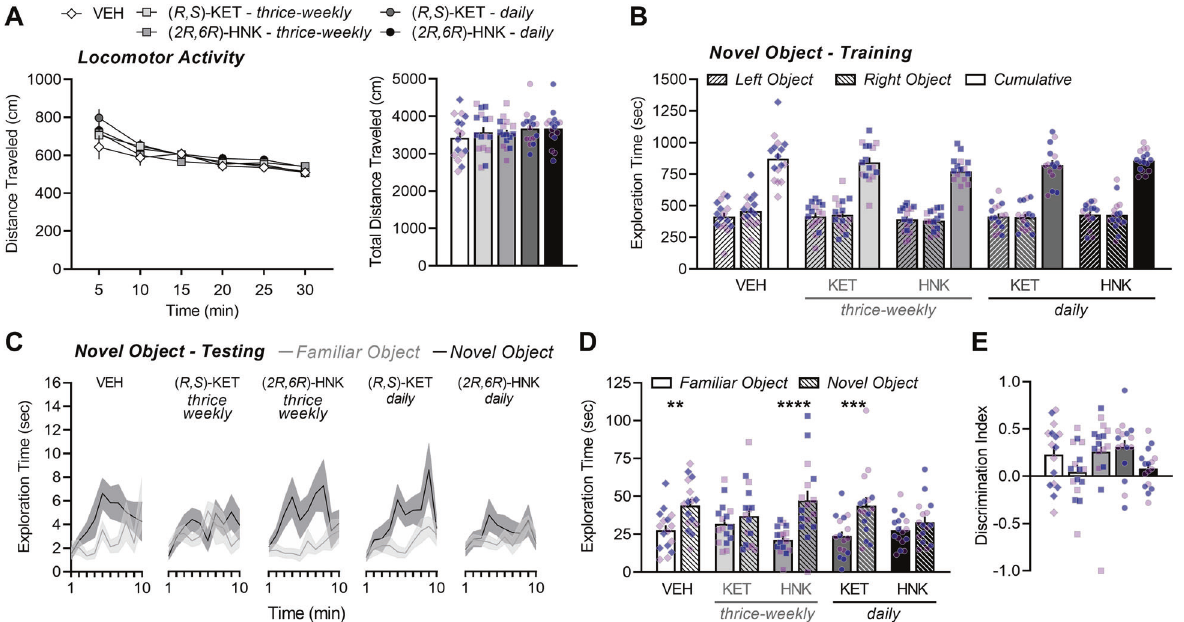
Fig. 3 Adolescents treated with thrice-weekly ( R,S )-ketamine or daily ( 2R,6R )-hydroxynorketamine have impaired novel object recognition in adulthood. A Locomotor activity during the habituation phase of the novel object-recognition task (i.e., in the absence of objects) plotted as 5-min time bins (left) and summarized as total distance traveled over the total 30-min (right). B Total time spent exploring two identical objects during the 30-min of training. C Time spent exploring the familiar object and the novel object across the 10-min of testing. D Total time spent exploring the familiar object and the novel object during the 10-min of testing and ( E ) plotted as a discrimination index (right): (novel-familiar)/(novel + familiar). Data are presented as mean ± standard error of the mean. ** P < 0.01, *** P < 0.001, **** P <